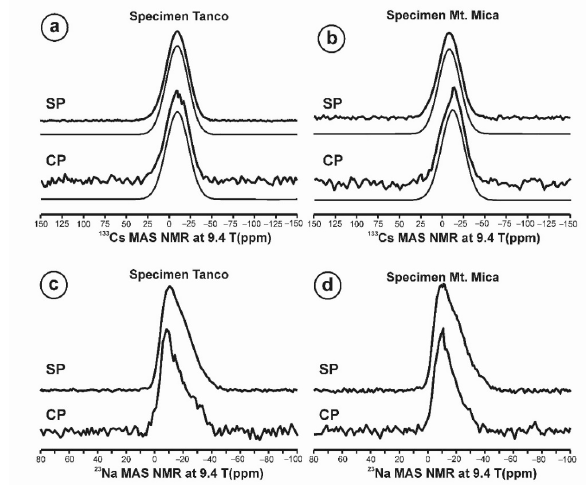
Figure 7. The NMR spectra of the cavity cations of the two specimens of pollucite at 9.4 T. ( a ) The 133 Cs SP-MAS spectrum and 133 Cs CP-MAS spectrum (contact time of 7 ms, number of scans 10,240, recycling time 5 s) of specimen Tanco simulated with Gaussian curves at −8.3 ppm and linewidth of 29.7 ppm for the SP experiment and at −9.9 ppm and a linewidth of 31 ppm for the CP experiment. ( b ) The 133 Cs SP-MAS spectrum of specimen Mt. Mica simulated with a Gaussian curve at −9.7 ppm and a linewidth of 30.11 ppm, for the SP experiment and at −11.87 ppm with linewidth of 31.63 ppm for the 133 Cs CP-MAS spectrum, with the same experimental conditions as in ( a ). ( c ) The 23 Na SP- MAS spectrum and 23 Na CP-MAS spectrum (contact time of 8 ms, number of scans 10,240, recycling time 5 s) at 9.4 T of specimen Tanco , with c.g. at −15.76 ppm in the SP experiment and −14.69 in the CP experiment. ( d ) The 23 Na MAS and CP MAS NMR spectra at 9.4 T of specimen Mt. Mica , with c.g. at −15.85 ppm in the SP experiment and −14.07 ppm in the CP experiment. The estimated experimental uncertainties in the chemical shift δ values are about 5 ppm for the 133 Cs spectra and circa 3 ppm for the 23 Na spectra.